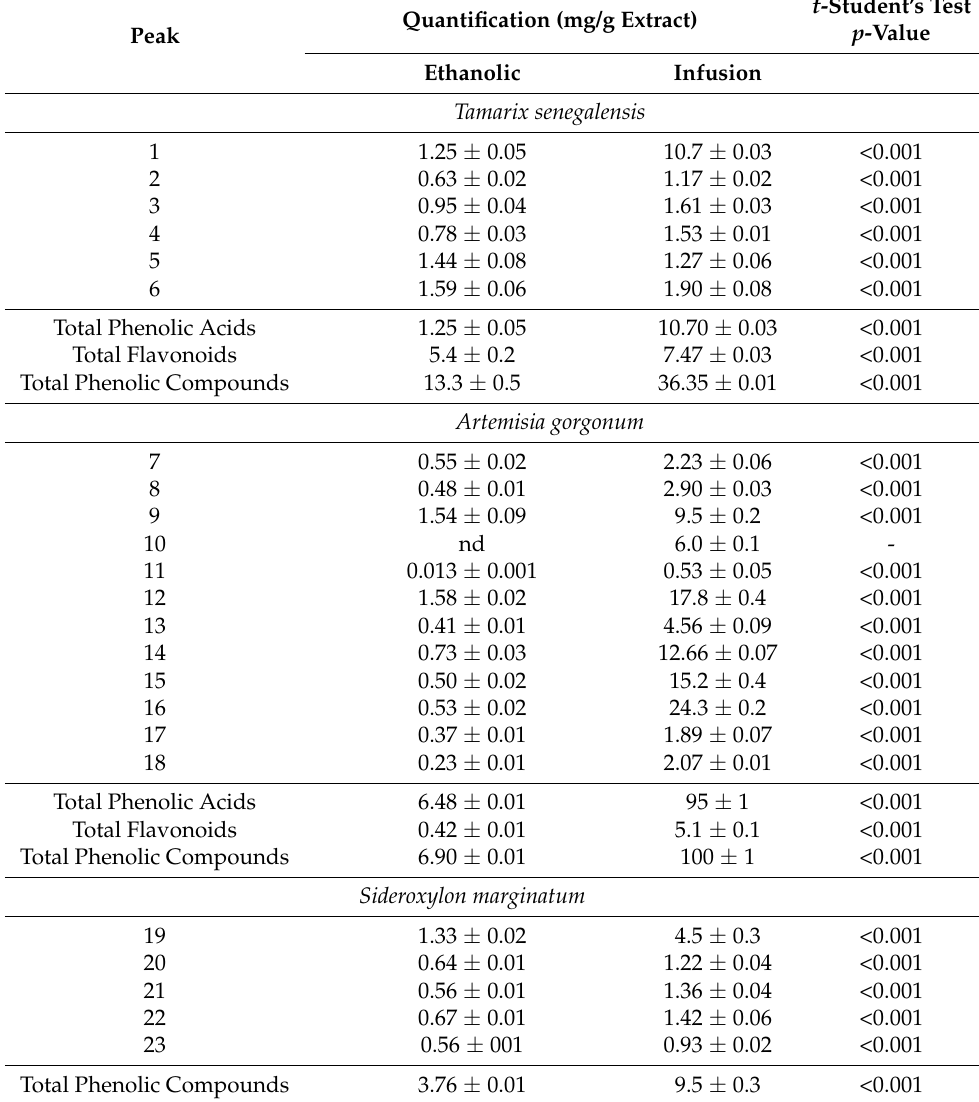
Table 3. Quantification (mg/g of extract) of the phenolic compounds present in T. senegalensis